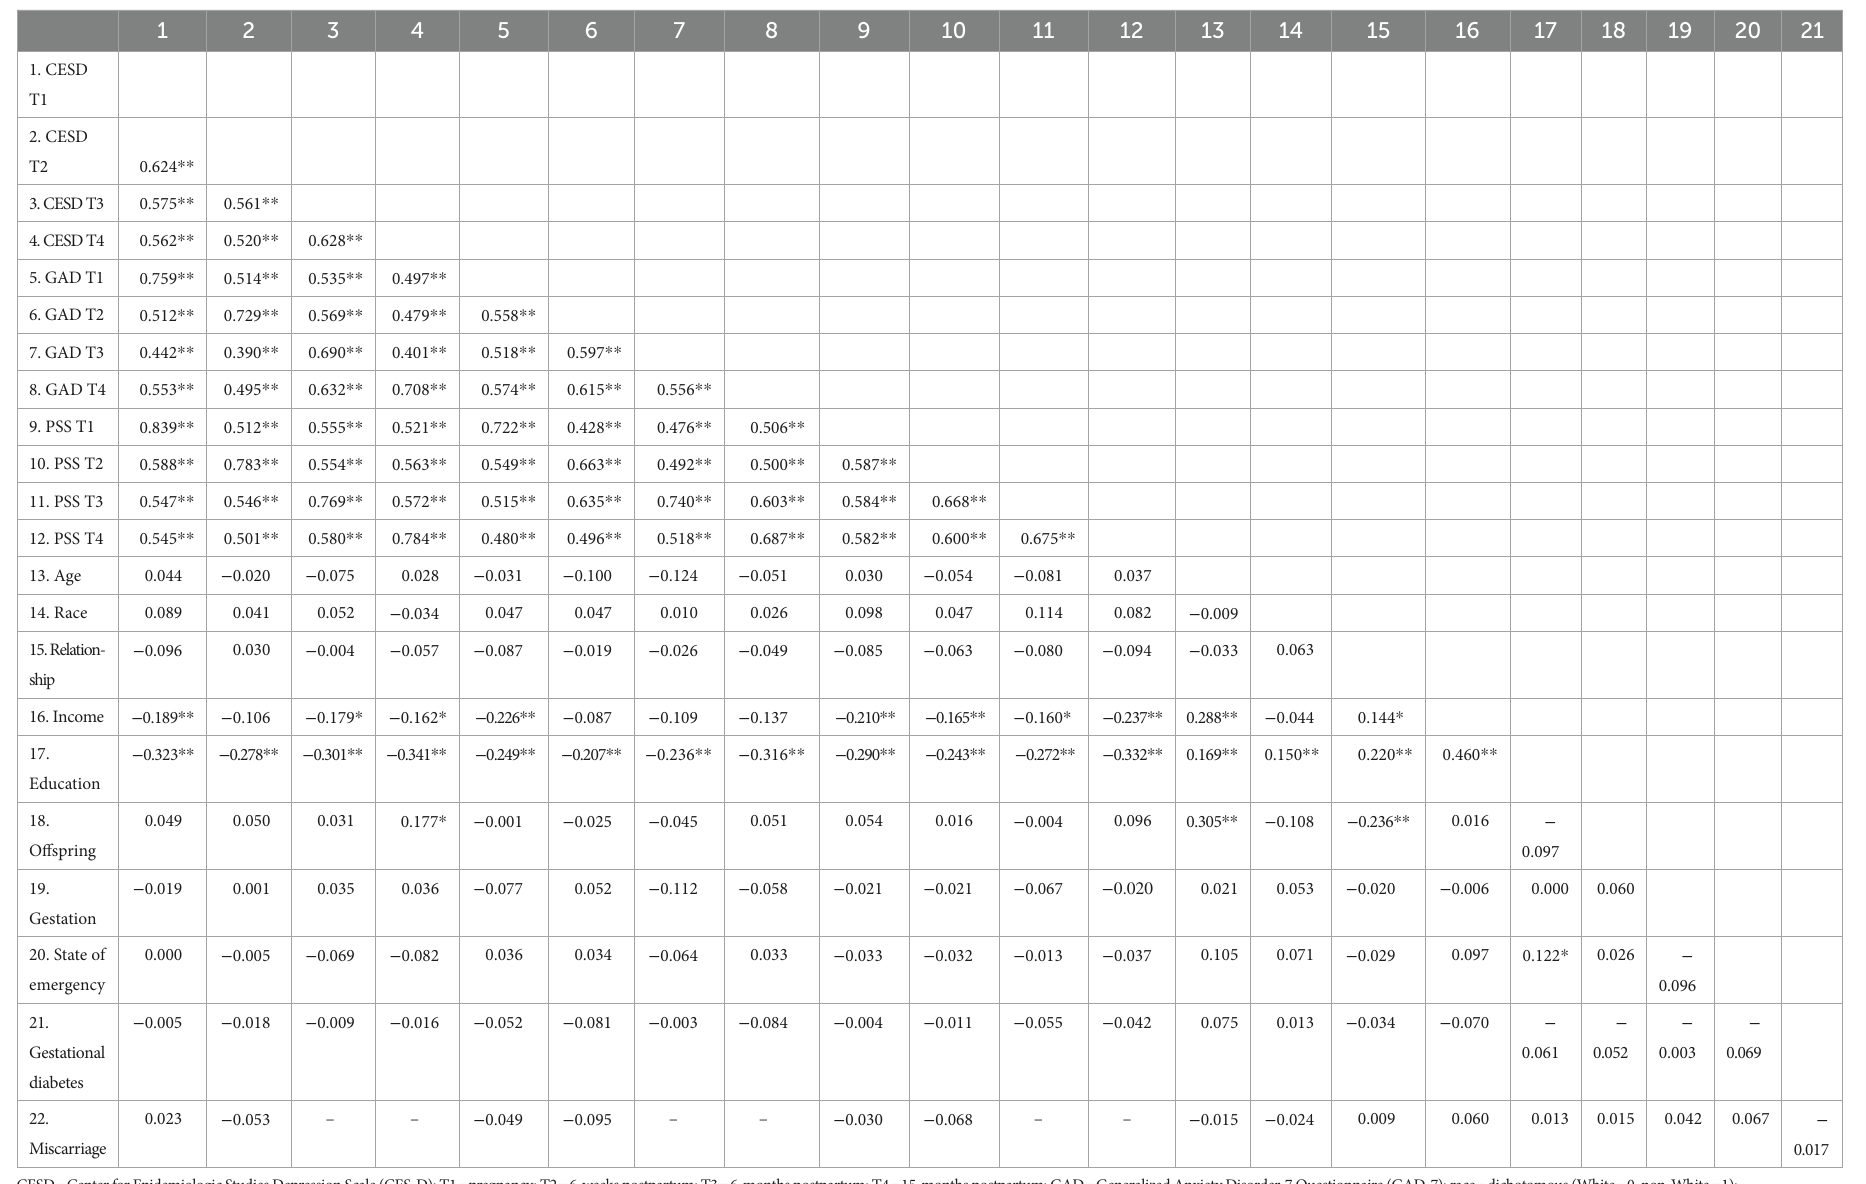
TABLE 2 Preliminary correlations: Outcome variables and potential